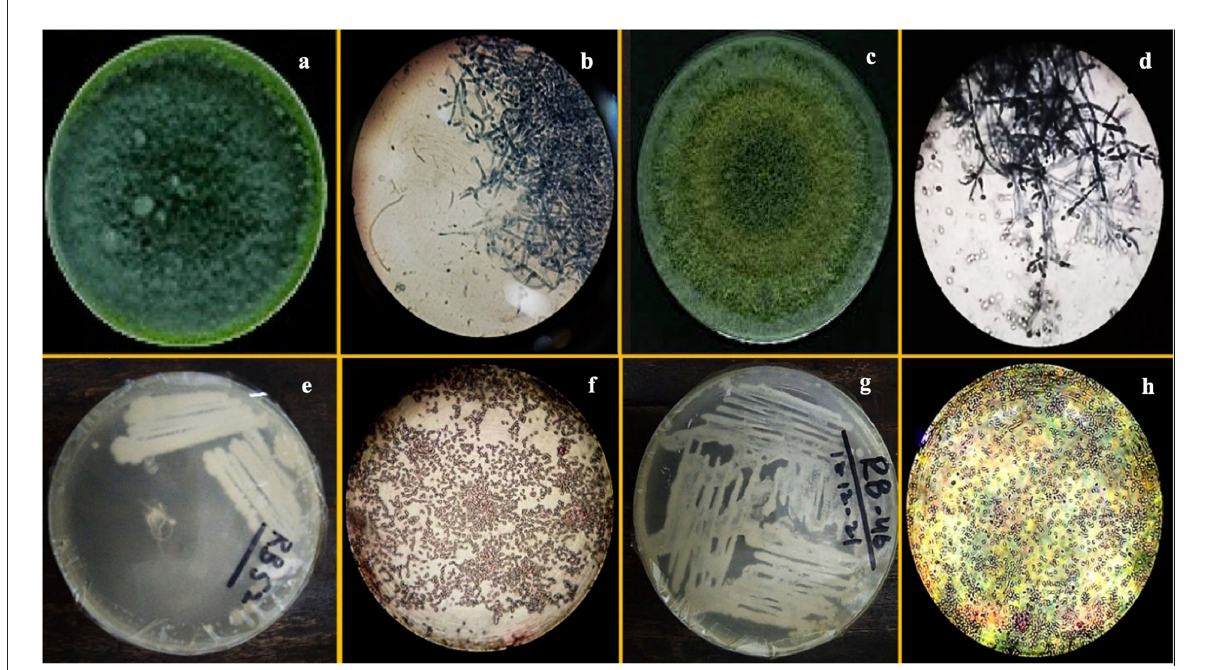
FIGURE1 Images of pure culture T. harzianum (a) inoculated plate (b) microscopic study, pure culture T. Viride (c) inoculated plate (d) microscopic study; images of pure culture Azotobacter nigricans sp. (e) inoculated plate (f) microscopic study and pure cultures Trichococcus sp. (g) inoculated plate (h) microscopic